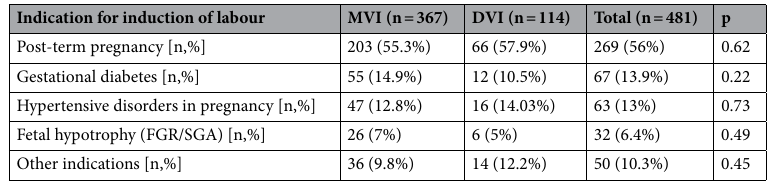
Table 2. Distribution of indication for IOL in particular groups. FGR fetal growth restriction, SGA small for gestation age.